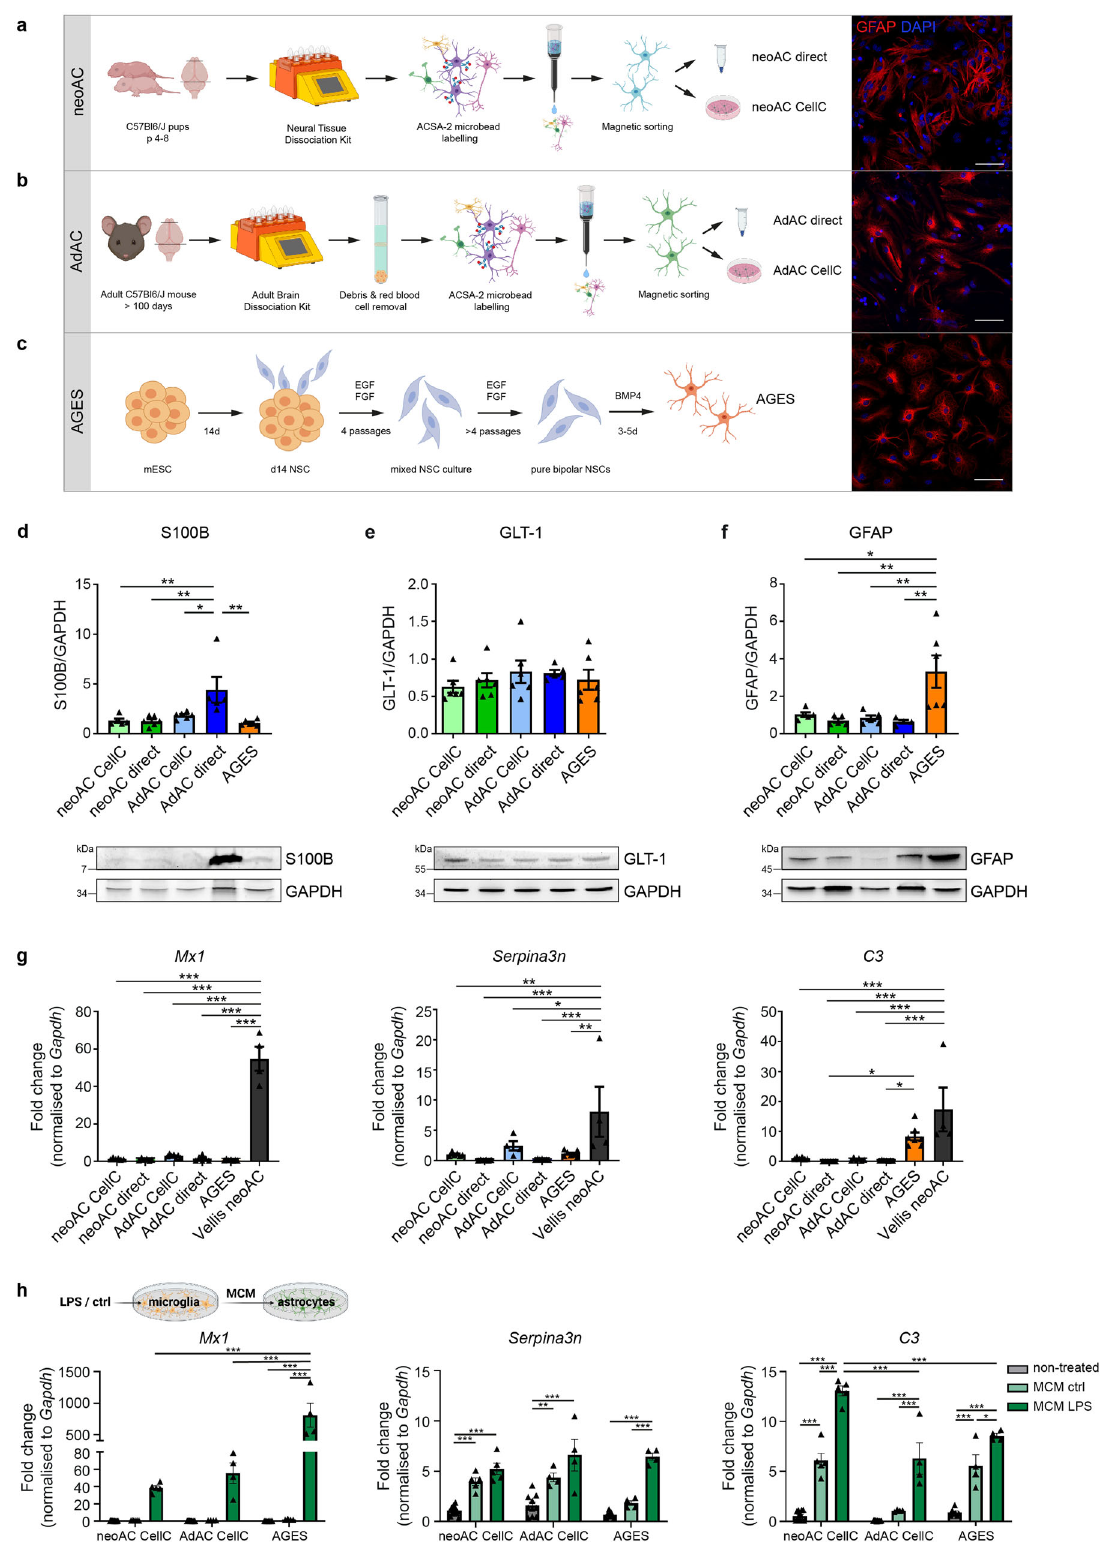
highly different between all astrocyte cultures showing a 20-fold higher expression of Mx1 in AGES and the highest upregulation of C3 in neonatal astrocytes (Fig. 1h). Taken together, our results highlight, when characterizing astrocyte cultures, a wide range of astrocytic and non-astrocytic markers should be used since the astrocyte subsets and